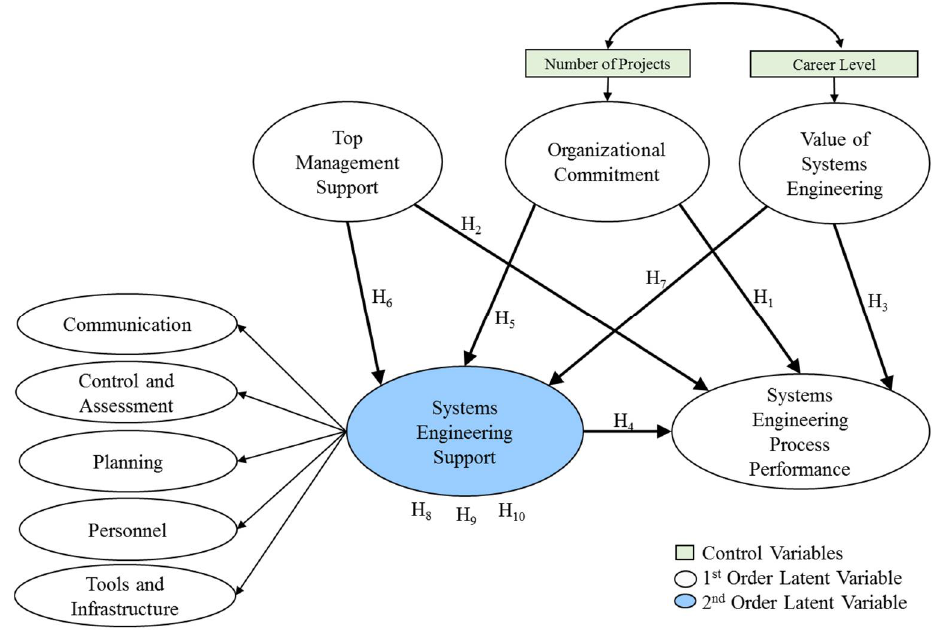
Figure 3. Hypothesized Model. Table 6. Confirmatory Factor Analysis and Validity